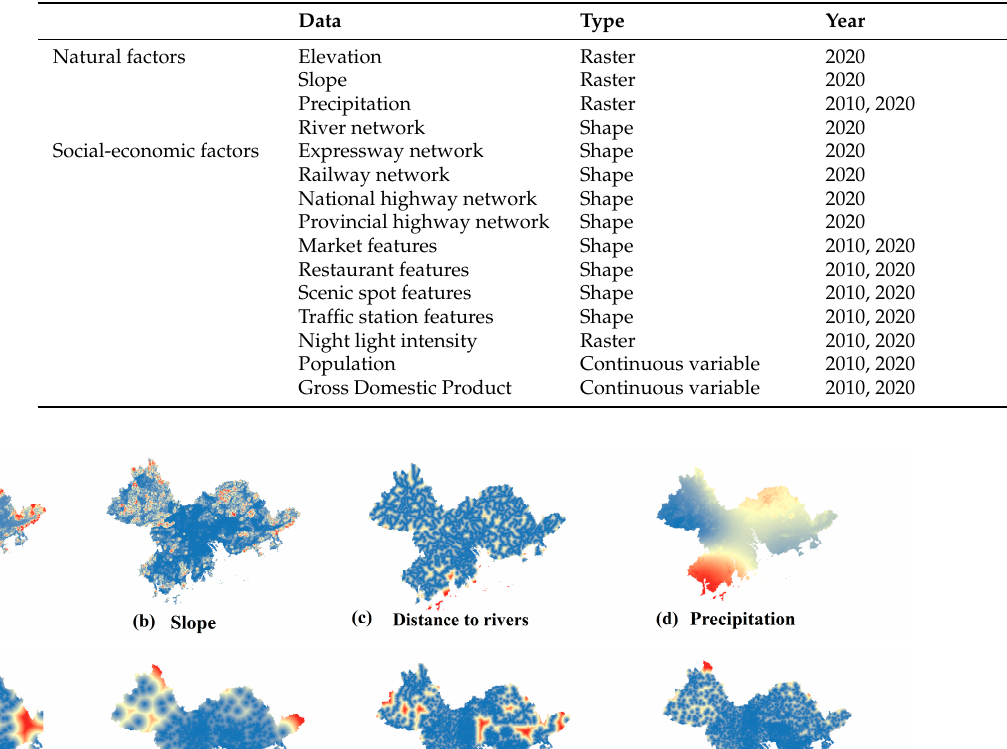
Table 1. Data used in the study.